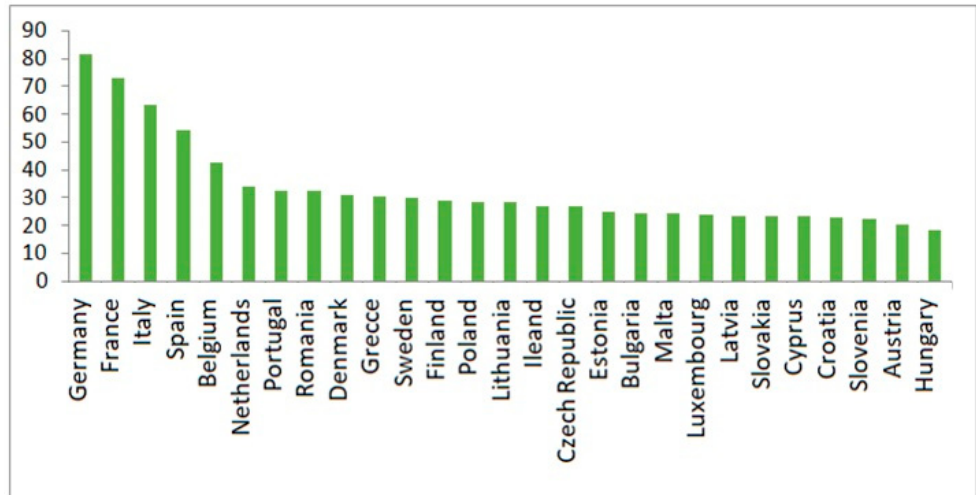
Figure 35. The significance of individual states in terms of the decisions taken